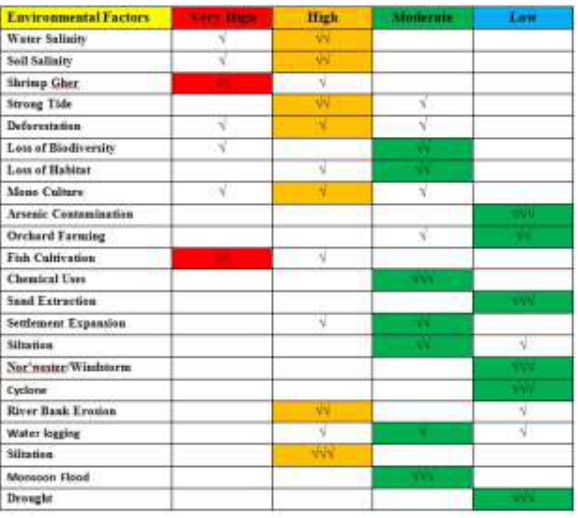
Table 6. Detailed environmental factors, impacts and sector wise spatial